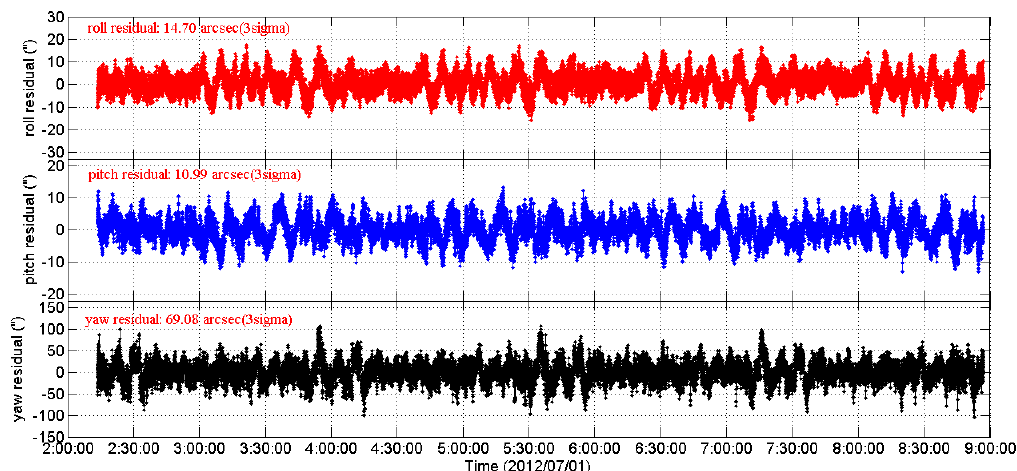
Figure 4. The 3-axes Euler angle residual streams of CCD01 as time series.